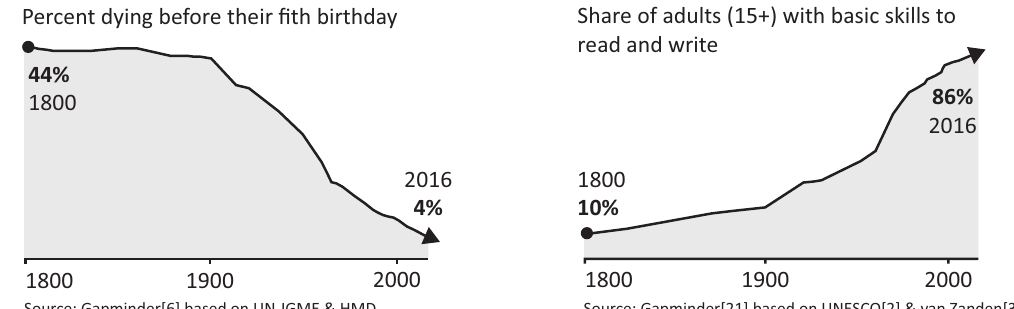
Figure 2. Examples of “bad things decreasing” and “good things increasing.” Note: See supplementary materials on